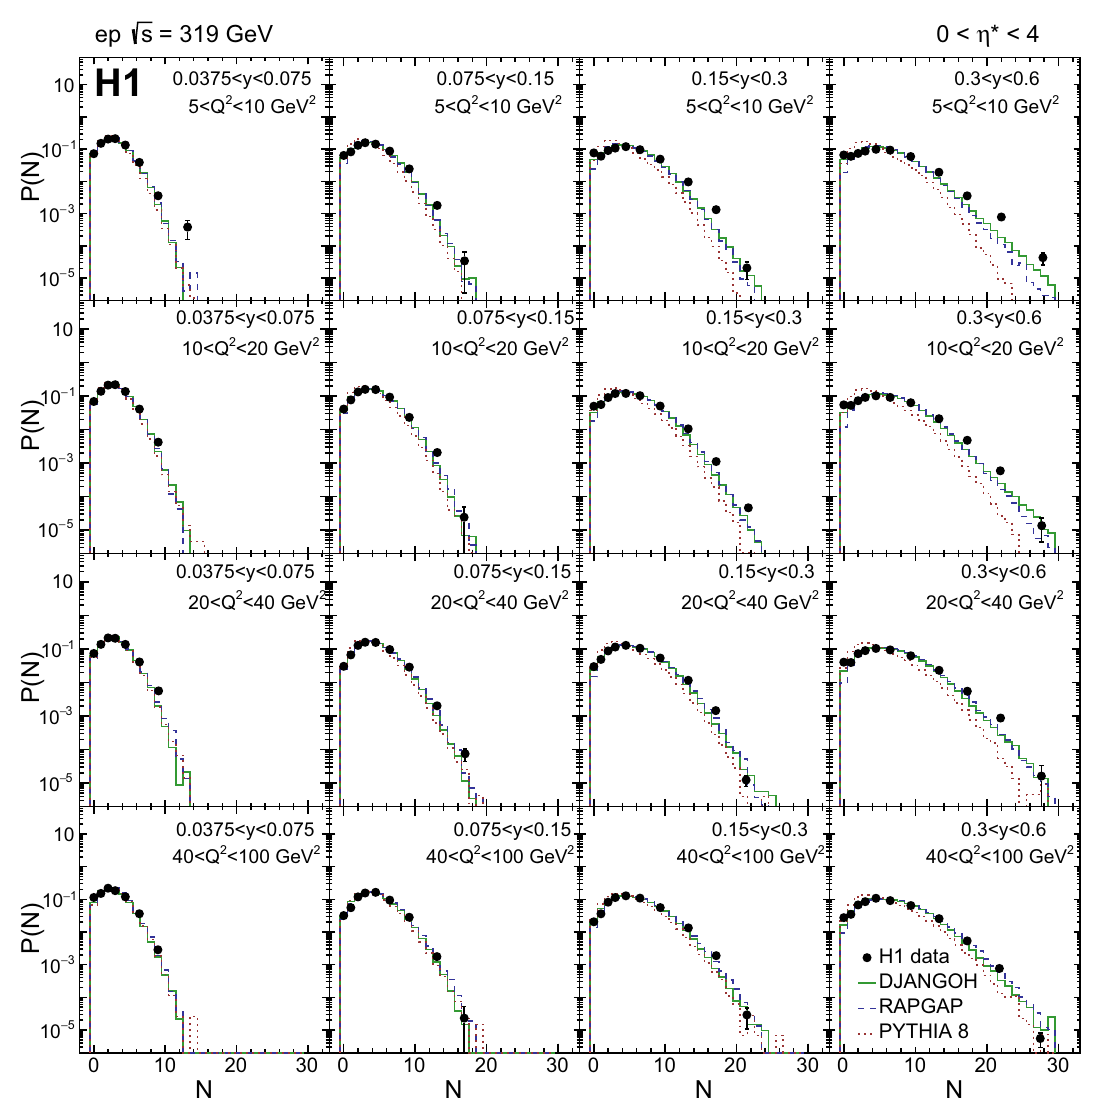
Fig. 7 Charged particle multiplicity distributions P ( N ) as a function different Q 2 and y bins, as indicated by the text in the figure. Predic- √ s = 319GeV ep collisions with addi- of the number of particles N at tions from DJANGOH, RAPGAP and PYTHIA 8 are also shown. The total uncertainty is denoted by the error tional restriction to the current hemisphere 0 < η ∗ < 4. Further phase space restrictions are given in Table 1. Different panels correspond to